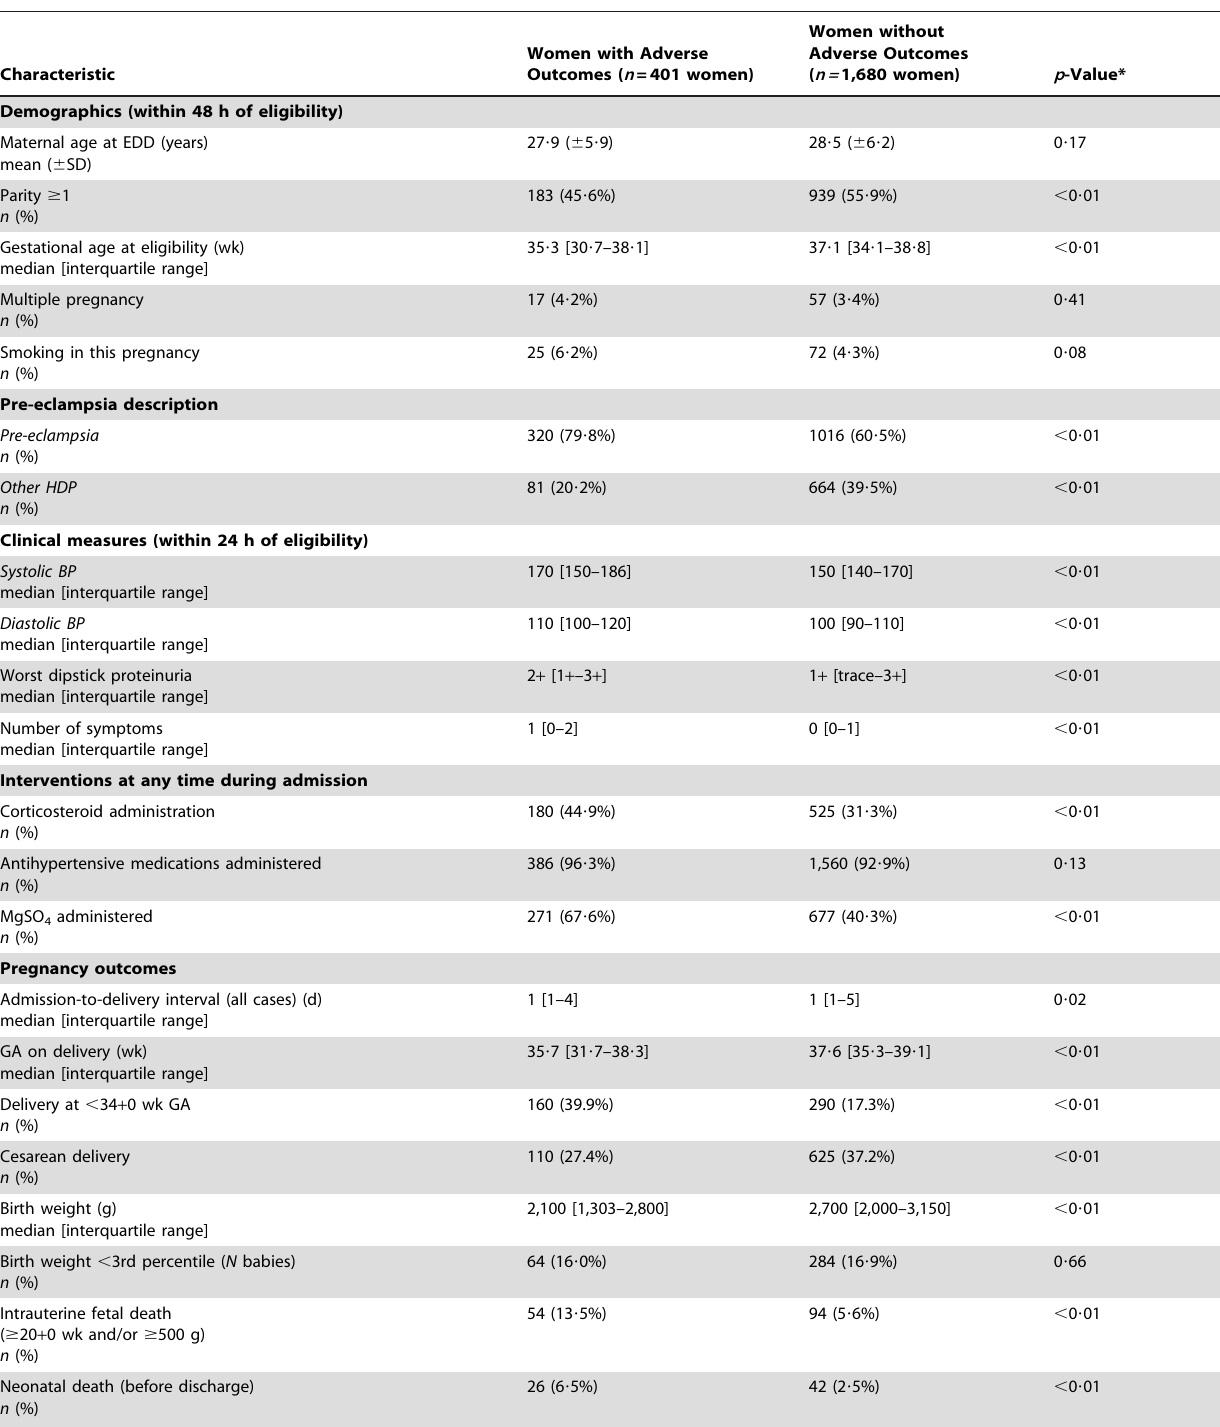
Table 1. Demographics of women in the total cohort comparing women with and without adverse maternal outcomes ( N = 2,081).